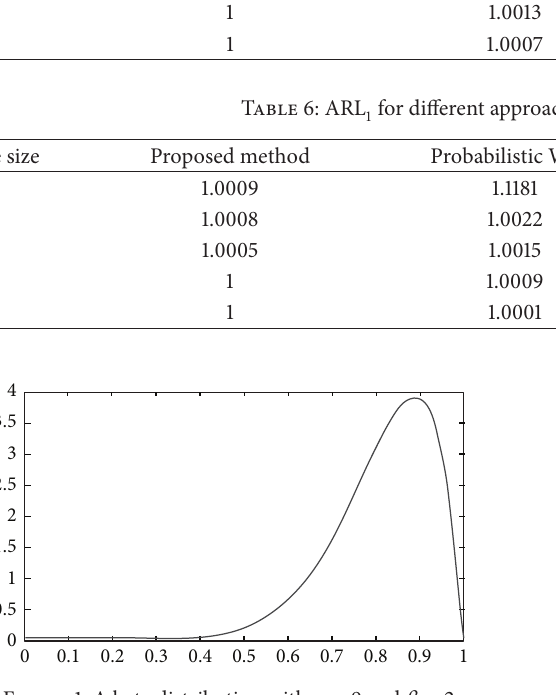
Figure 1: A beta distribution with 𝛼 = 9 and 𝛽 = 2